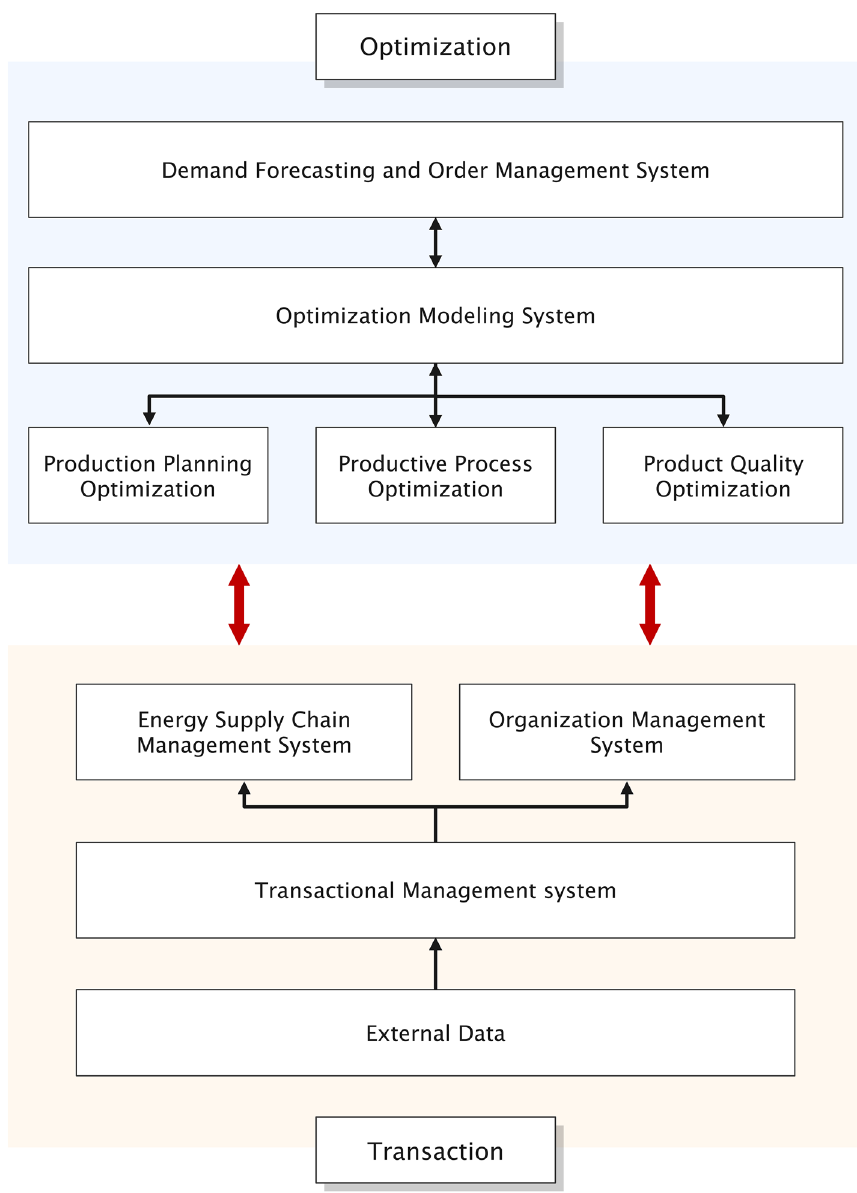
Fig. 4 Schematic of enterprise-wide